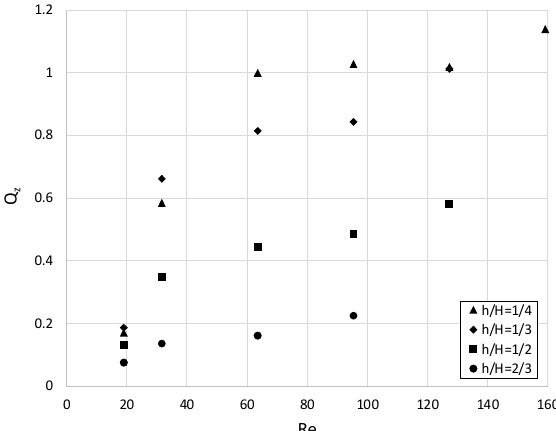
Fig. 6. Mean axial pumping capacity Q z / N · d 3 for novel impeller in function of Reynolds number and for different impeller distances from tank